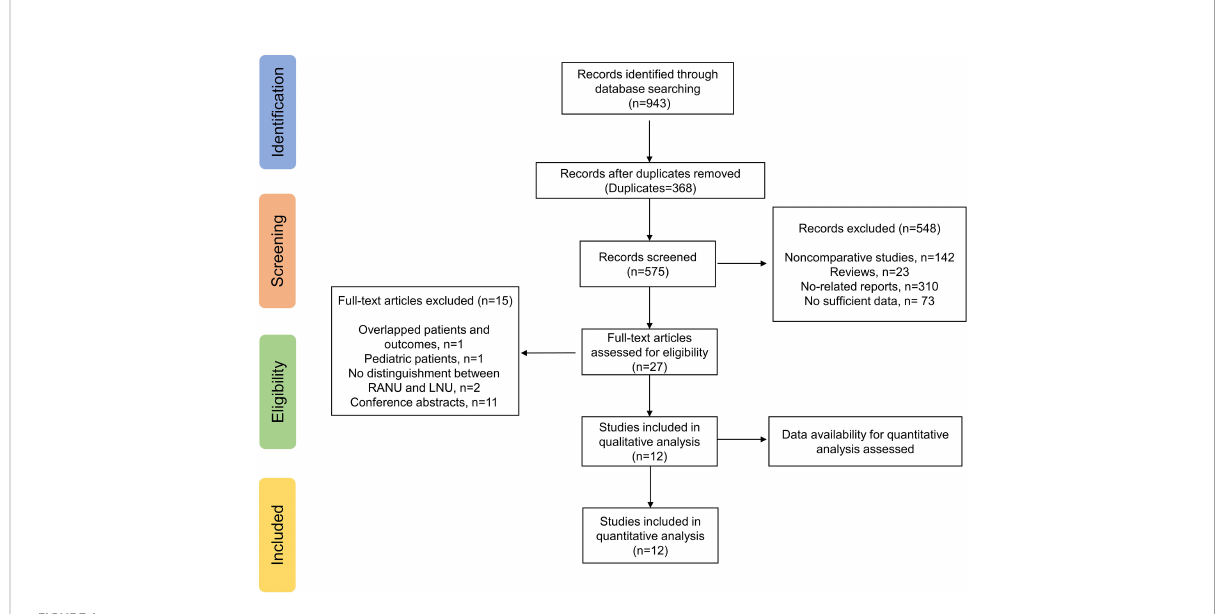
FIGURE 1 Study fl ow